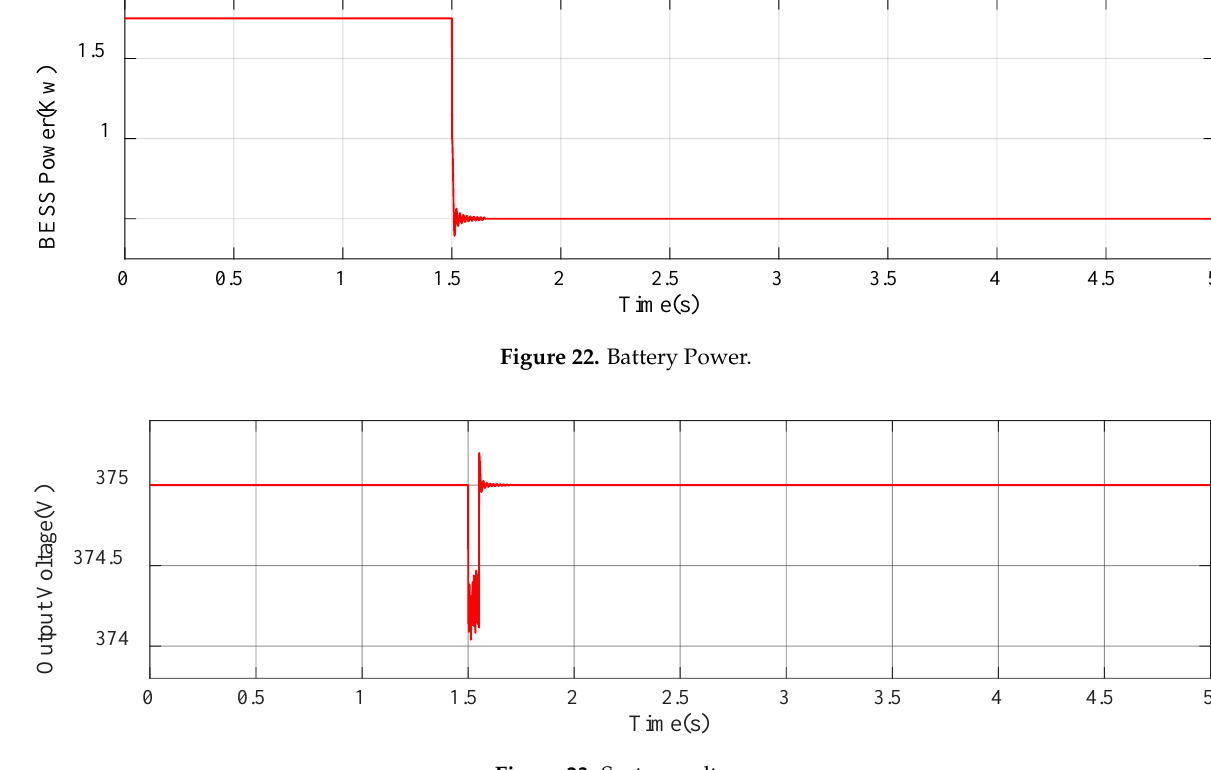
Figure 23. System Figure 23. System voltage. Figure 23. System voltage.